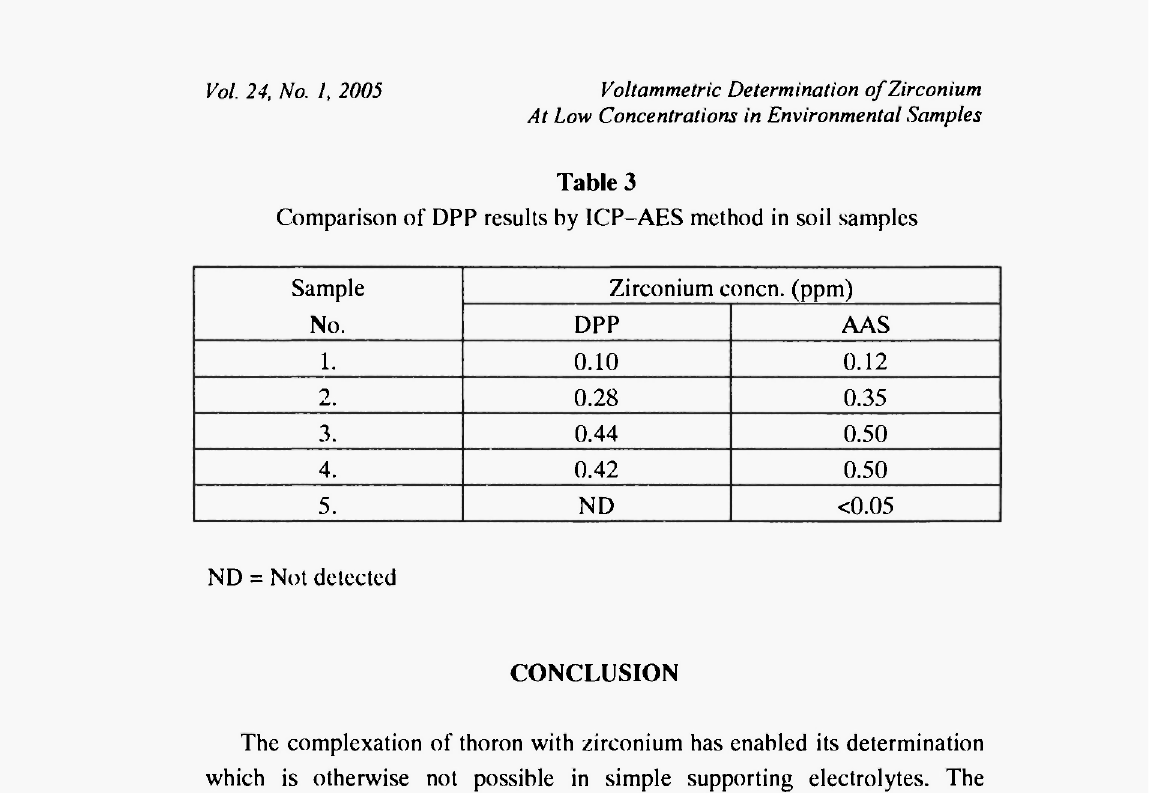
Comparison of DPP results by ICP-AES method in soil samples Sample Zirconium concn.